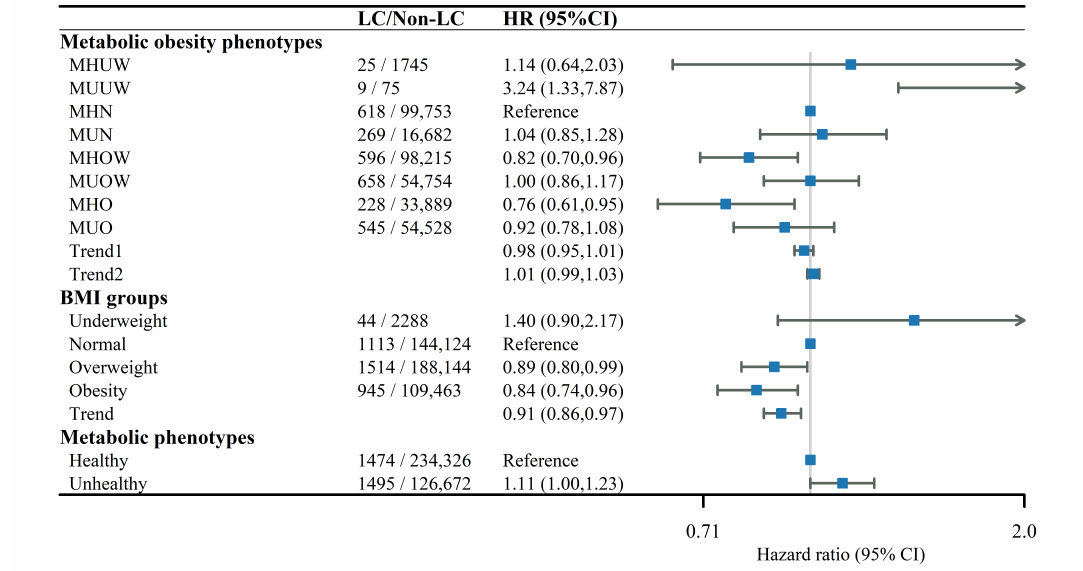
Figure 1. Association between metabolic obesity phenotypes and LC. HRs: hazard ratios; LC: lung cancer; BMI, body mass index; MHUW, metabolically healthy underweight; MHN, metabol- ically healthy normal; MHO, metabolically healthy obesity; MHOW, metabolically healthy over- weight; MUUW, metabolically unhealthy underweight; MUN, metabolically unhealthy normal; MUO, metabolically unhealthy obesity; MUOW, metabolically unhealthy